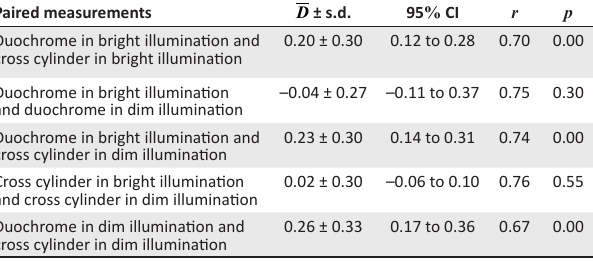
TABLE 2: Mean differences ( D or Xd ), 95 % confidence intervals and correlation between the duochrome and unfused cross cylinder tests. Paired measurements D ± s.d. 95 % CI r p Duochrome in bright illumination and cross cylinder in bright